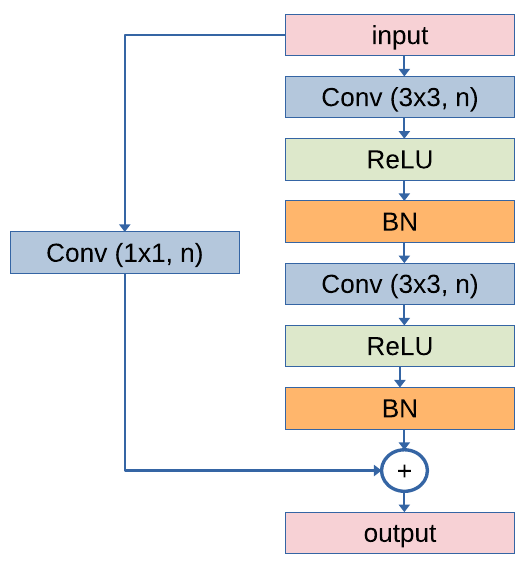
Figure 1. ConvRes block used in the proposed architecture. Conv( t × t , n ) stands for convolution with t × t kernel and n filters, ReLU - activation with rectifier linear unit, BN - batch